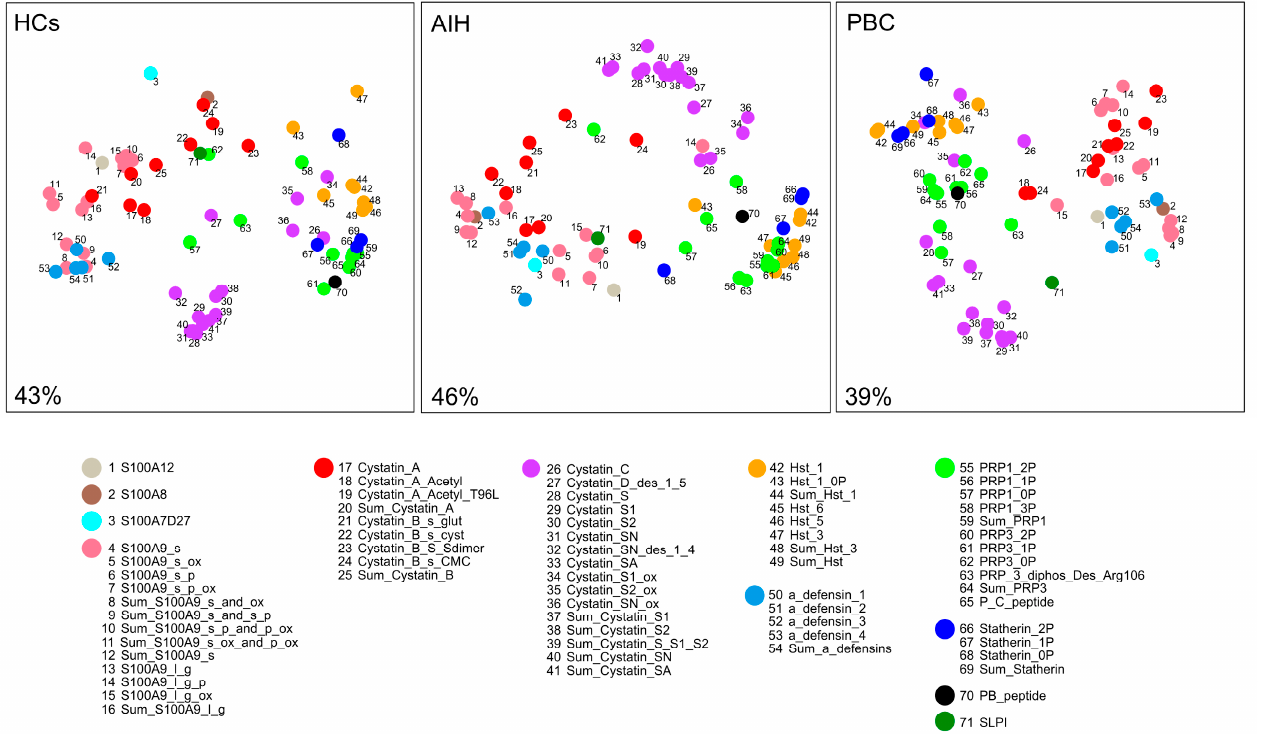
Figure 2. Multidimensional scaling (MDS) diagrams of Kendall correlations among protein levels in the HCs, AIHp and PBCp groups. To facilitate the understanding of the diagrams, the 71 com- ponents were grouped into different categories, numerically and color encoded, based on their structural/functional similitudes and secretory origin. The degree of clustering of points accounts for the degree of proteins/peptides co-expression. Percent values indicate how much two-dimensional diagrams represent the information contained in the whole multi-dimensional structure.